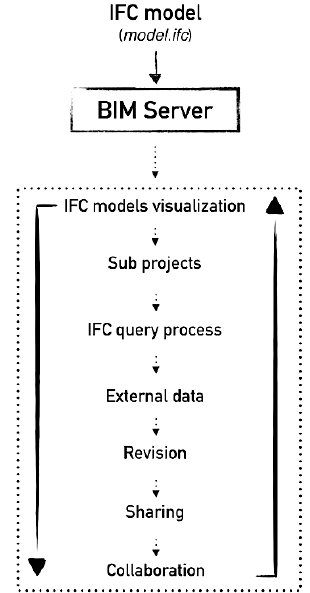
Figure 5. Example of a basic workflow by using BIM Server